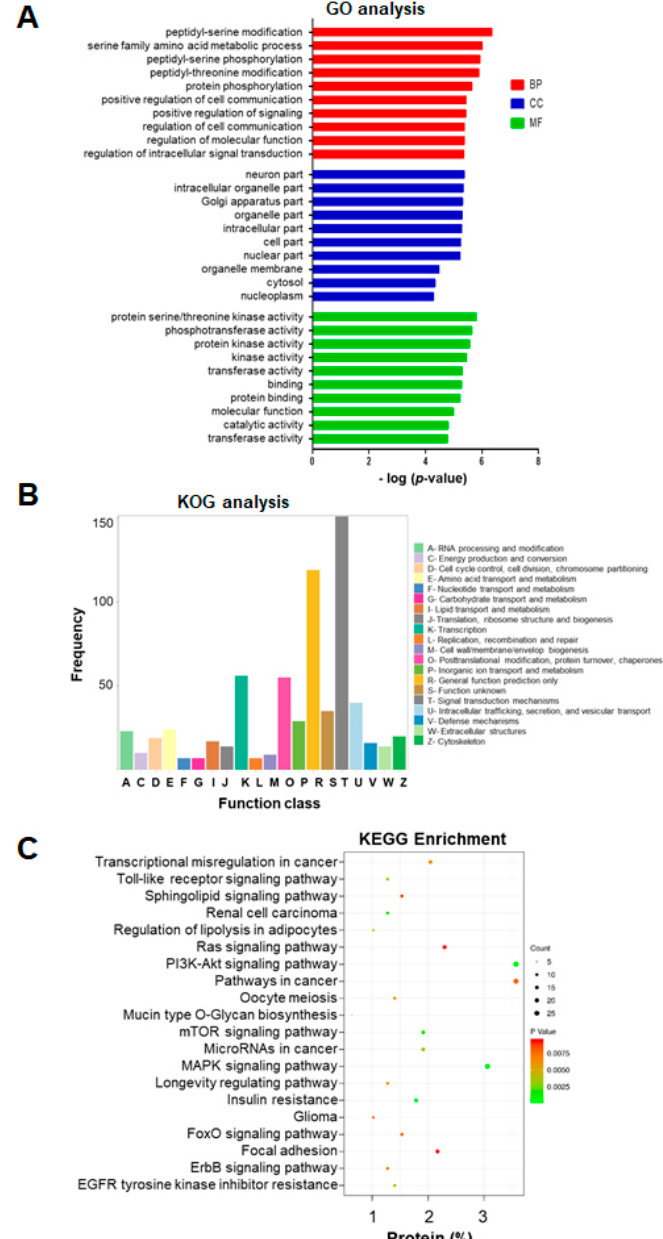
Figure 4. Gene Ontology (GO) analysis, eukaryotic orthologous groups (KOG) functional classification, and Kyoto Encyclopedia of Genes and Genomes (KEGG) pathway analysis of target genes (mRNAs) regulated by the 19 miRNAs that were di ff erentially expressed between young and old rats. ( A ) GO annotation of predicted targets. The top 10 most enriched GO terms are listed in terms for biological process (BP), cellular component (CC), and molecular function (MF) based on p -values. ( B ) KOG functional classification of target genes. The vertical axis represents the frequency of target genes classified into the specific categories, and the horizontal axis represents the KOG functional classification. ( C ) The top 20 most common KEGG pathways of the di ff erentially expressed mRNAs regulated by the 19 miRNAs. Fold change > 1.5 and p < 0.05. GO, gene ontology; KOG, eukaryotic orthologous groups; KEGG, Kyoto Encyclopedia of Genes and Genomes.